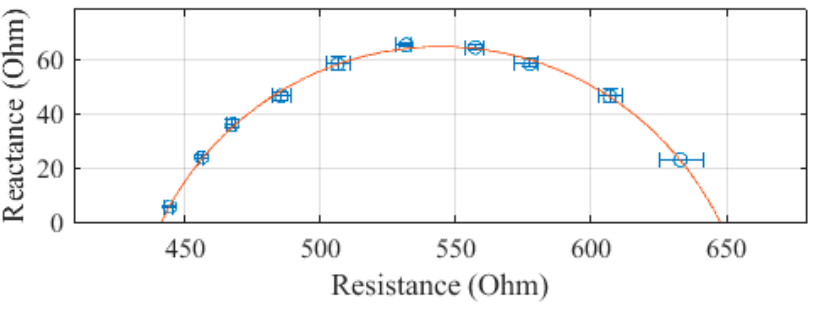
Figure 4. Cole–Cole plot of the whole-body impedance of subject 1 measured with the